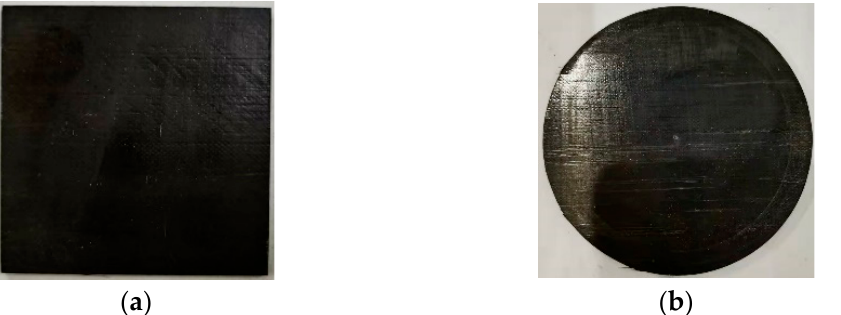
Figure 2. Square and circular CFRP specimens. ( a ) Square CFRP specimens; ( b ) circular CFRP specimens.